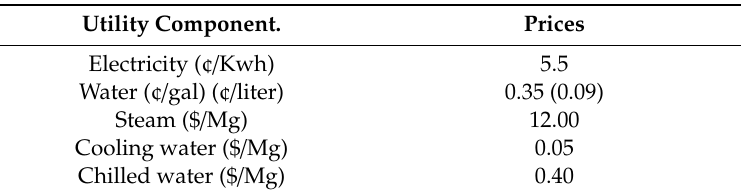
Table 2. Utility prices [19].